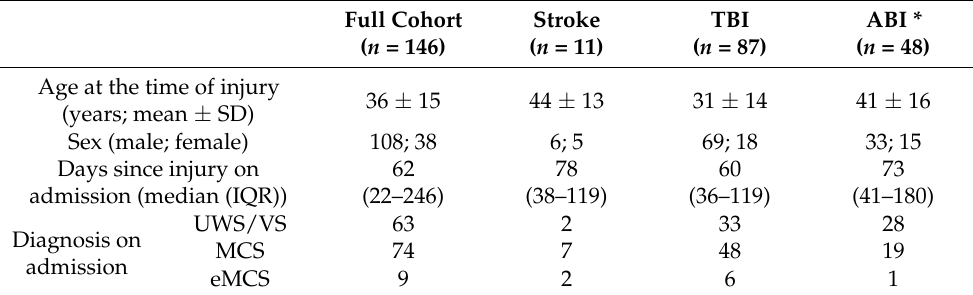
Table 1. Basic demographic information of the 146